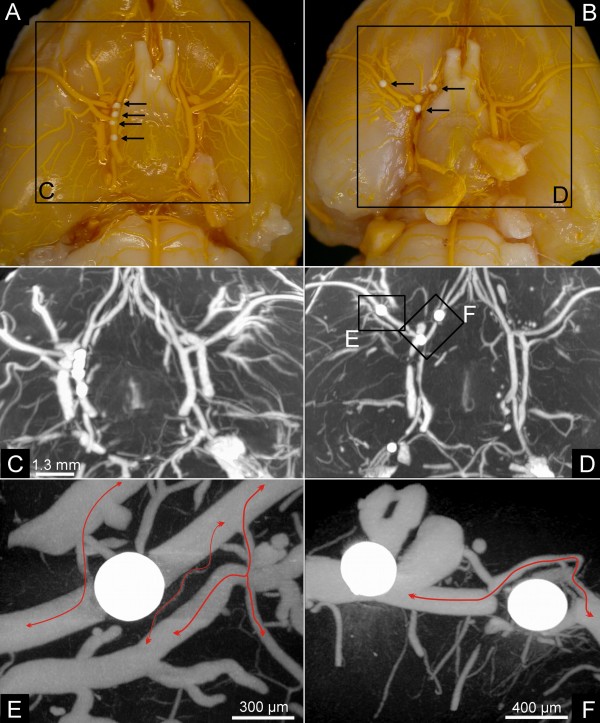
Macrosphere Model. Macroscopic image (A, B) of macrospheres present in the circle of Willis (A) and in the circle of Willis, the anterior cerebral artery and the middle cerebral artery (B). Micro-CT maximum intensity projection (C, D) also demonstrate the macrosphere perfusion territories. Nano-CT imaging (E, F) demonstrate collateral perfusion with contrast-enhanced afferent and efferent vessel perfusion.